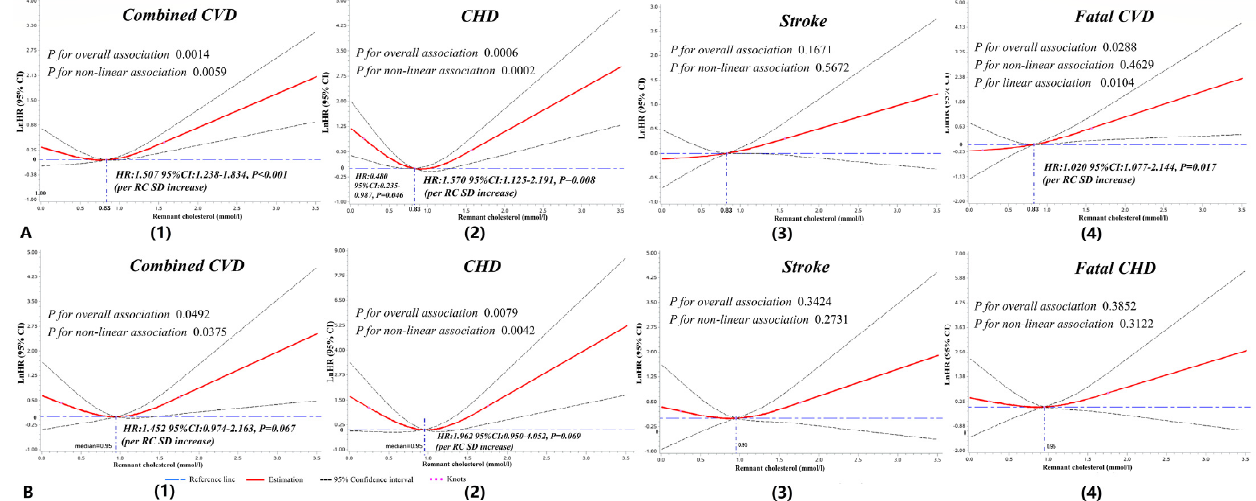
Figure 4. Dose-response associations between RC and cardiovascular outcomes for subgroups aged < 65 years and DM. Restricted cubic splines displaying the lnHRs of cardiovascular events among participants aged < 65 years ( A (1–4)) and diabetes ( B (1–4)) with 95% confidence intervals according to the serum level of remnant cholesterol. Reference set to the medians (0.83 mmol/L for subgroups aged < 65 years, 0.95 mmol/L for the diabetes mellitus subgroup). Knots located at the 5th, 50th, and 95th percentiles of remnant cholesterol (subgroup aged < 65 years: 0.17, 0.83, and 1.57 mmol/L; DM: 0.25, 0.95, and 1.76 mmol/L). Adjusted for age, sex, ethnicity, body mass index, smoking status, drinking status, hypertension, DM, estimated glomerular filtration rate, hyperuricemia, and continuous triglyceride. CHD, coronary heart disease; CVD, cardiovascular disease; DM, diabetes mellitus; HR, hazard ratio; lnHRs, natural log of hazard ratios; RC, remnant cholesterol; SD, standard deviation.